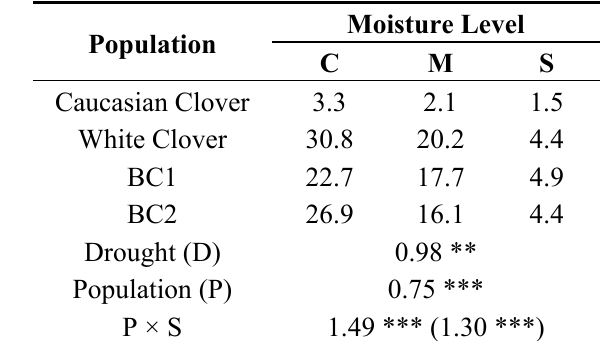
Table 5. Dry matter yield (g/plant) of Caucasian clover, white clover, BC1 and BC2 hybrids after 35 days at three levels of drought. C––control treatment, M––moderate moisture stress, S-severe moisture stress.